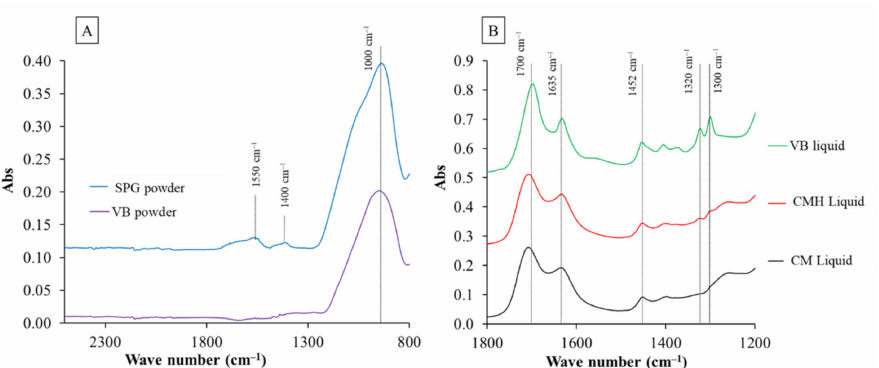
Figure 2. ( A ) The FTIR results of the powder phase; and ( B ) the FTIR spectra were obtained from the liquid phases of the RMGICs used in the current studies. VB is the commercial RMGIC (Vitrebond). Reproduced with permission under a Creative Common Attribution License from Thepveera et al. (2021). Reprinted with permission from